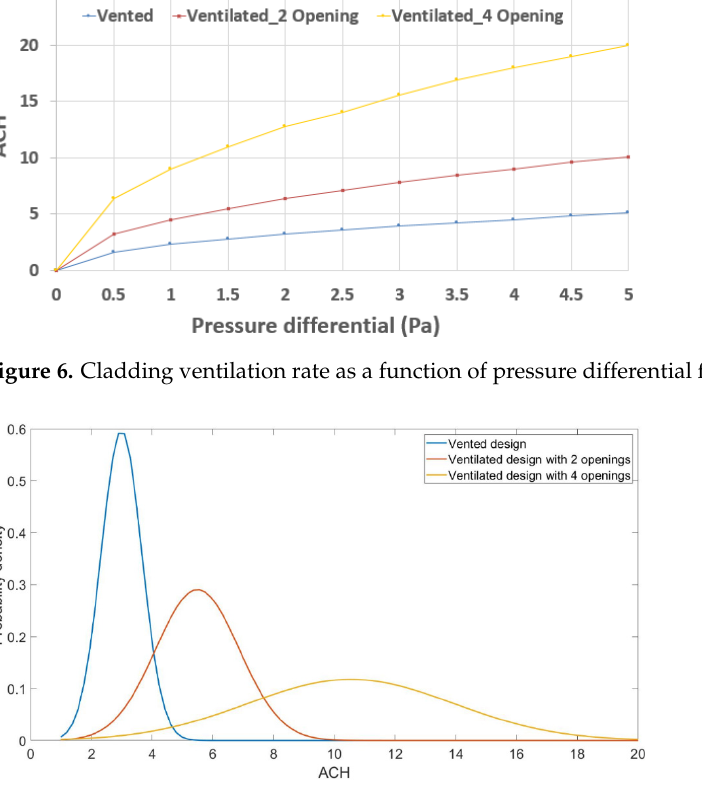
Table 7. Literature review on A-value and effective saturation water content of brick. Authors